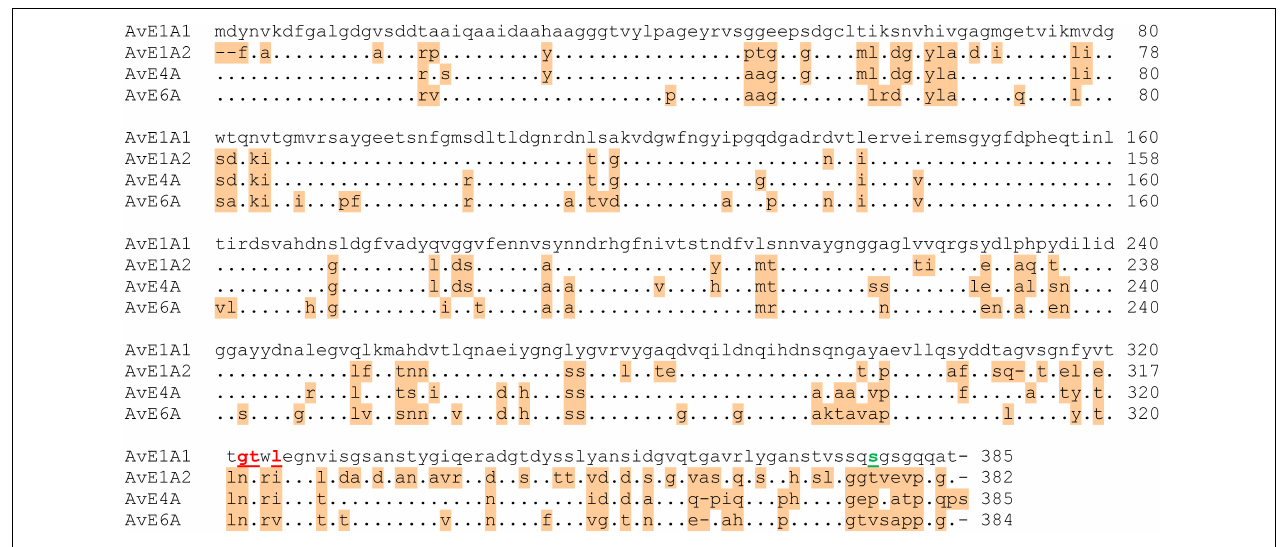
FIGURE 4 | Alignment of the A-modules of AlgE1, AlgE4, and AlgE6 emphasizing the differences between the first A module of AlgE1 (A1) and the other three A-modules. Dots indicate identical amino acids whereas amino acids differing are shaded. The amino acid identified as the N-terminal in the degraded AlgE1 produced by H. polymorpha is shown in green, while the ones identified by incubation of supernatant from H. polymorpha with purified AlgE1 is marked in